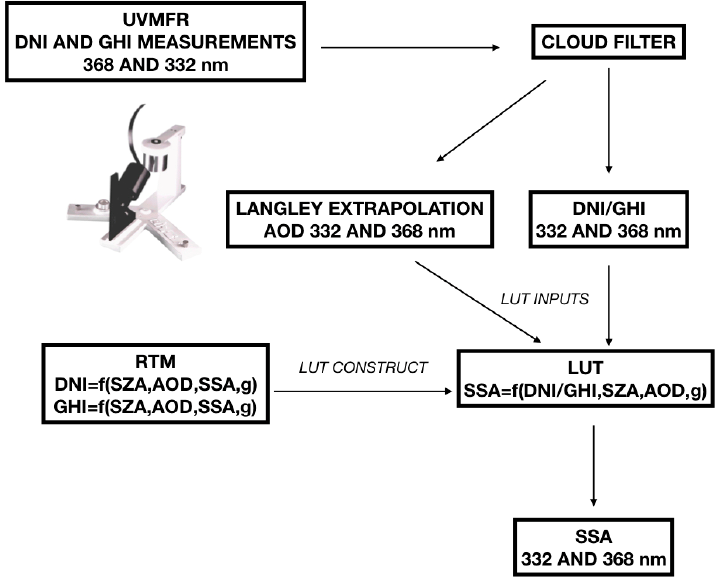
Figure 1. Flow chart of the methodology followed to retrieve SSA from UVFMR measurements [8].